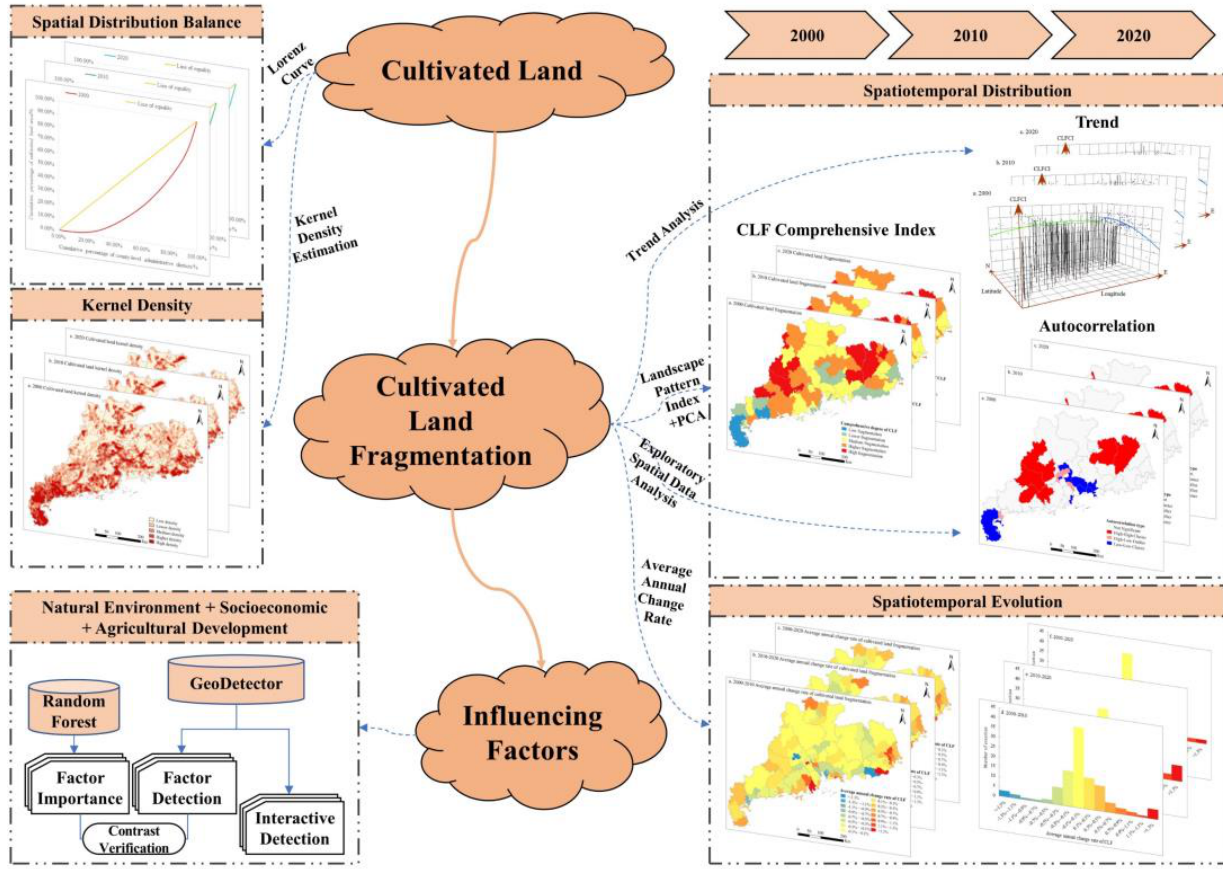
Figure 2. General research framework.